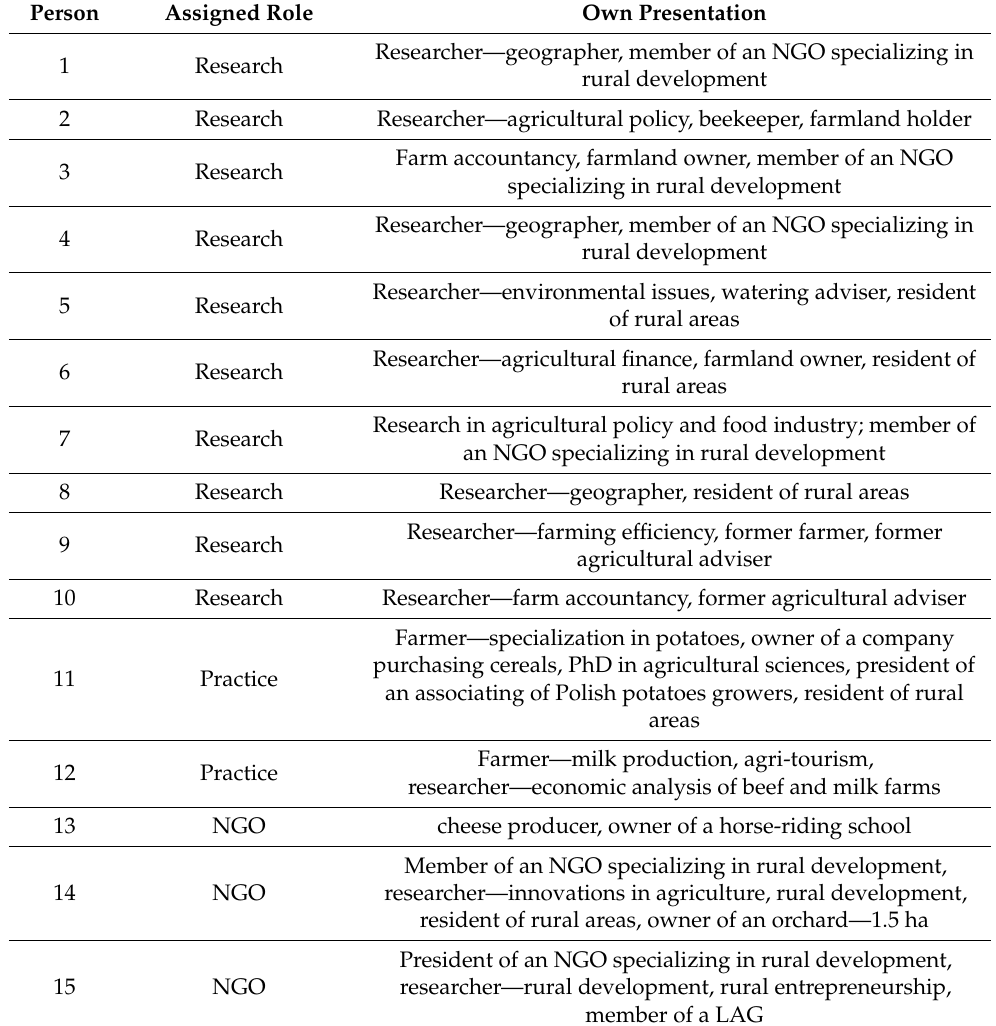
Table 1. Presentation of the